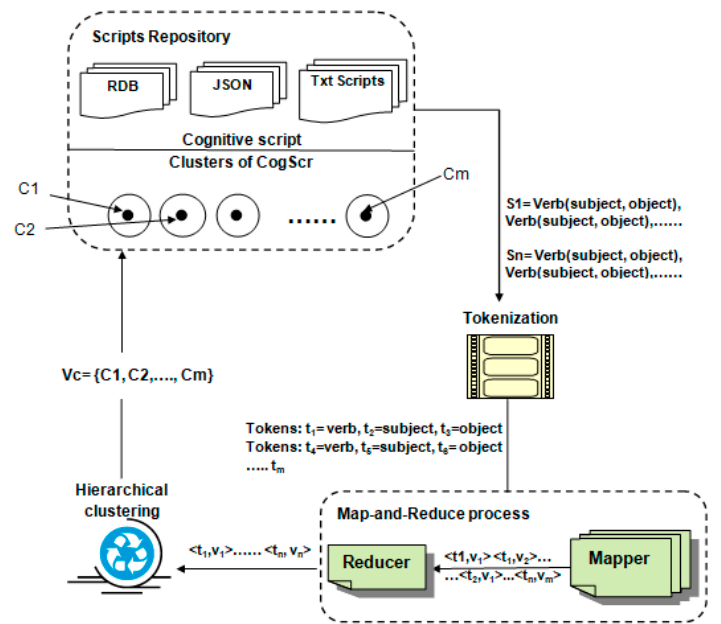
Figure 3. Hierarchical clustering algorithm based on Figure 3 . Hierarchical clustering algorithm based on map-and-reduce .